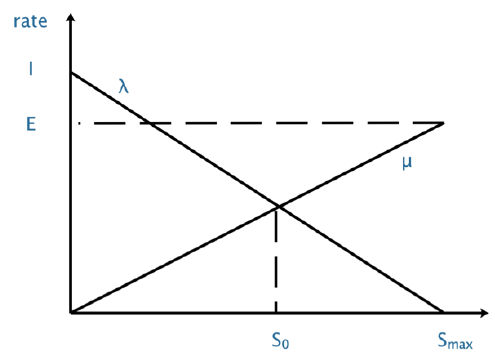
Figure 4. Relationship plot of species number and migration